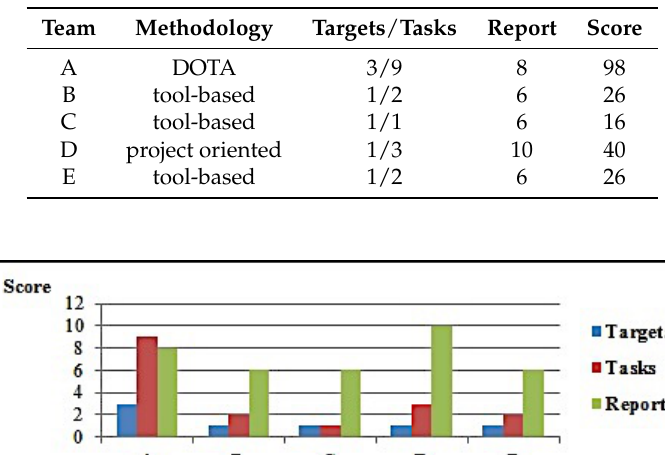
Table 4. Results: Third test.